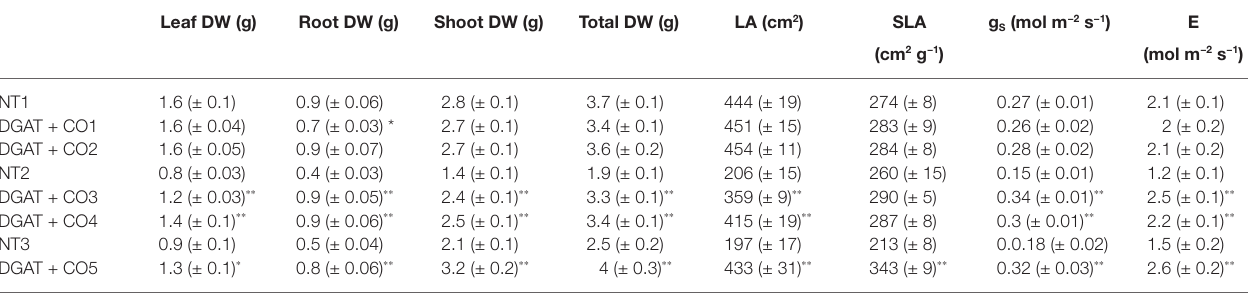
TABLE 2 | Growth and gas exchange parameters for five DGAT + CO lines and three NT control lines 3 weeks after